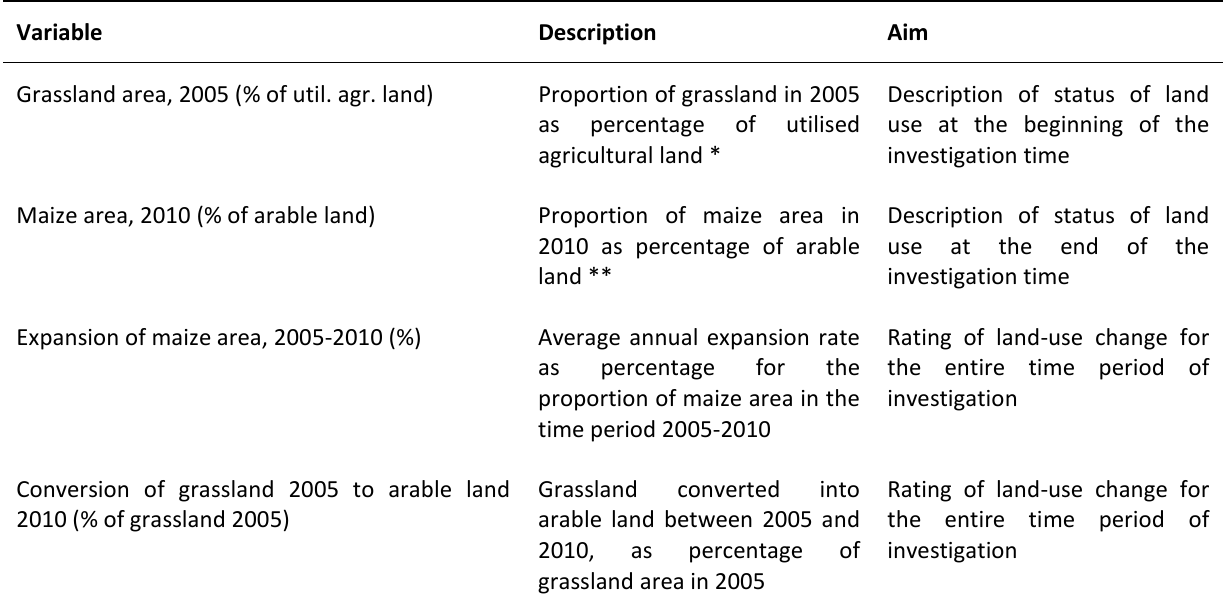
Table 3: Variables of agricultural land use used for k-means cluster analysis to detect types of agricultural land-use patterns and dynamics (TLPDs)